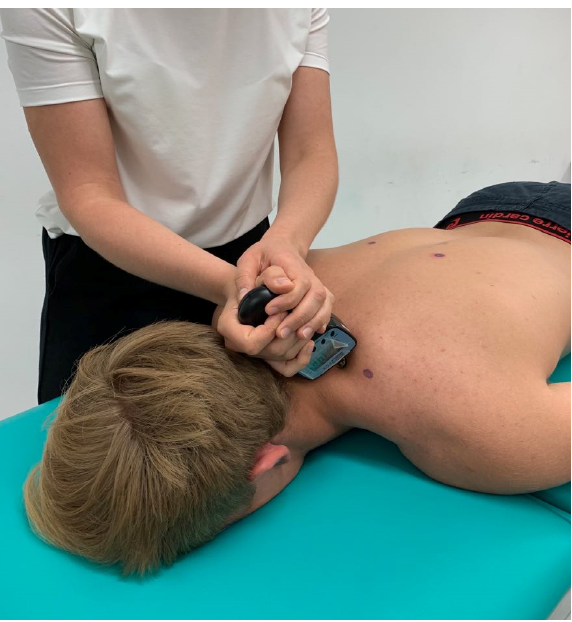
Figure 2. Algometric measurement of levator scapulae muscle trigger point.